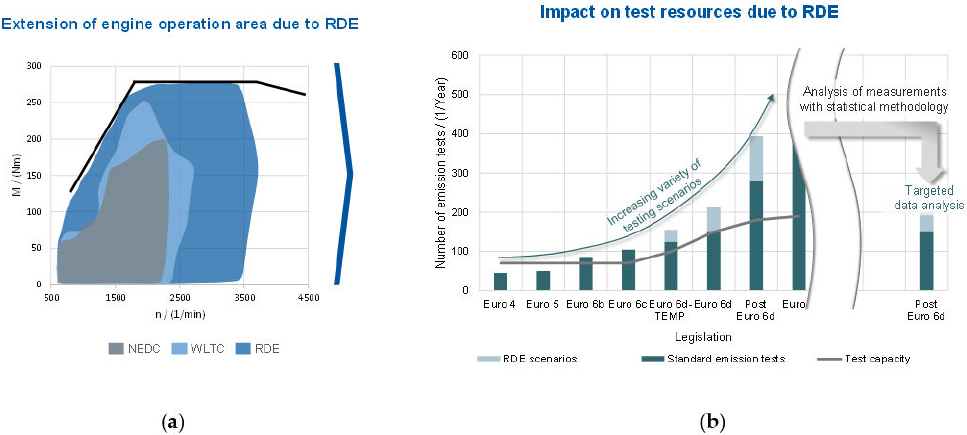
Figure 1. ( a ) Comparison of operating point ranges used in NEDC, WLTC and representative RDE test; ( b ) Impact on required testing capacity of different European emission legislation